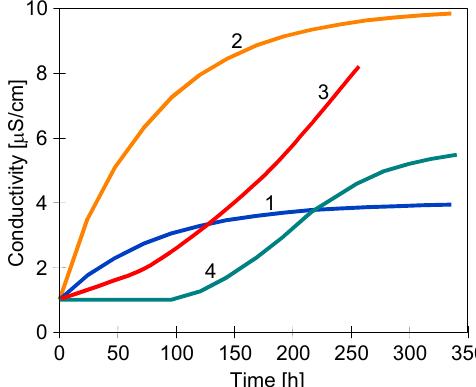
Figure 2. The results of model calculation presented the influence of feed leakage intensity on changes of electrical conductivity of water circulated on the distillate side. The permeate constitutes 25 vol. %/per day of the volume of circulated water. Curves 1 and 2: permeate conductivity 4 and 10 µ S/cm, respectively. Curve 3—permeate conductivity increased every day 1 µ S/cm. Curve 4—mixed conditions: non leakage, leakage increases, and leakage stabilized.